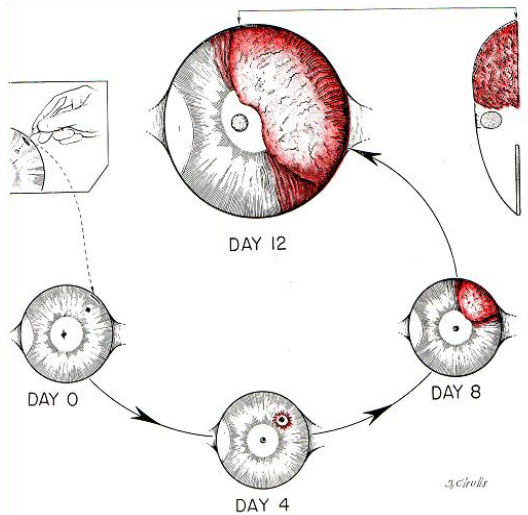
Figure 1. The patterns of development of two simultaneous implants of Brown-Pearce tumor in the rabbit eye. Tumors suspended in the aqueous fluid of the anterior chamber of the rabbit eye and observed for a period up to 6 weeks remain viable, avascular, of limited size (less than 1 mm 3 ) and contain a population of viable and mitotically active tumor cells. After implantation contiguous to the iris, which has abundant blood vessels, the tumors induced neovascularization and grow rapidly, reaching 16,000 times the original size within two weeks. The anterior chamber implant remains avascular, while the iris implant vascularizes and grow progressively. (Reproduced from [31]).